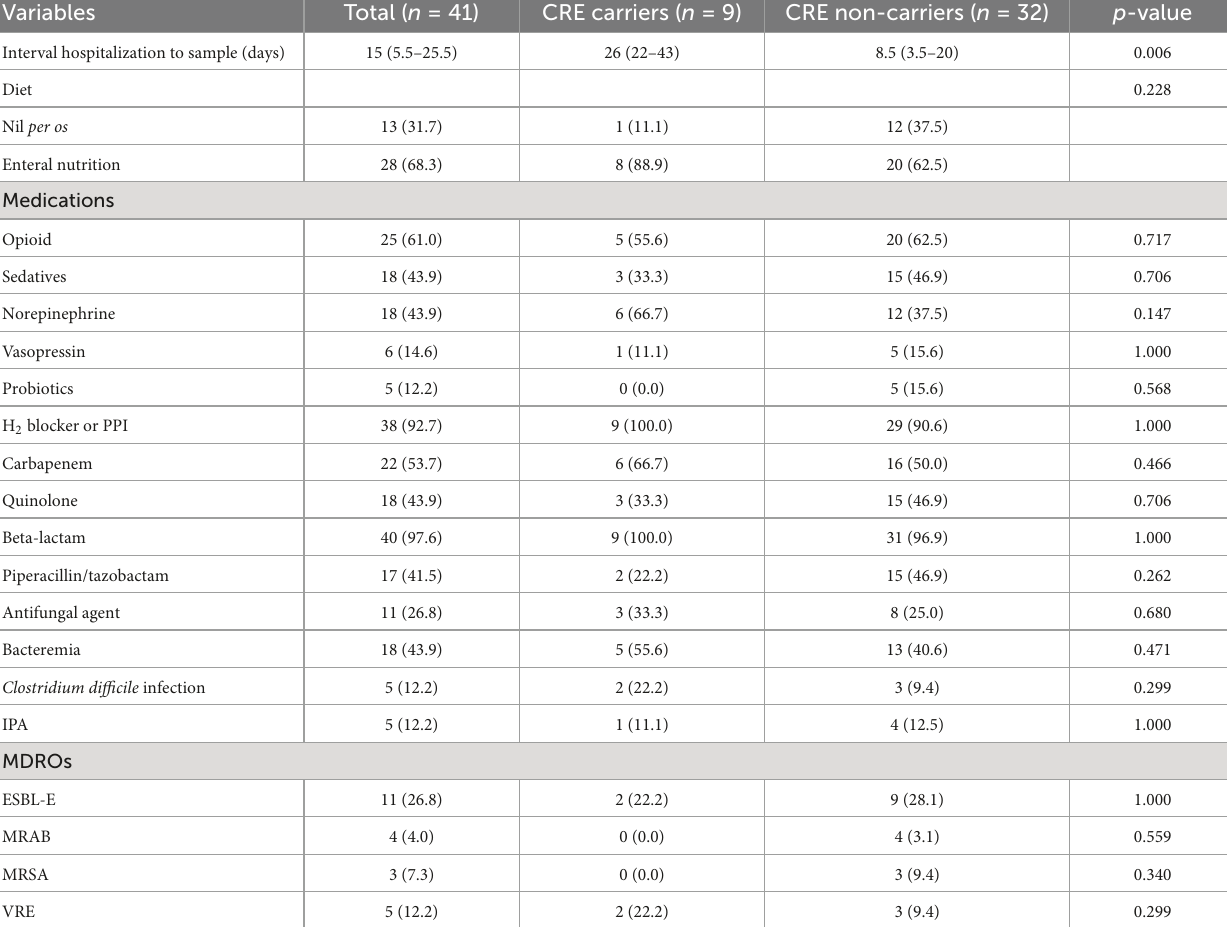
TABLE 2 Medications and CRE carrier status at fecal sampling of the participants. Variables Total ( n = 41) CRE carriers ( n = 9) CRE non-carriers ( n = 32) p -value Interval hospitalization to sample